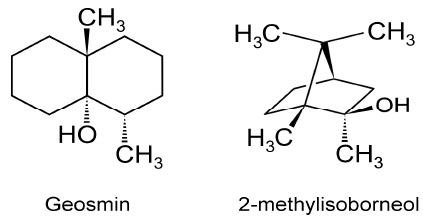
Figure 7. Chemical structures of two key T&O compounds, geosmin, and 2-MIB.